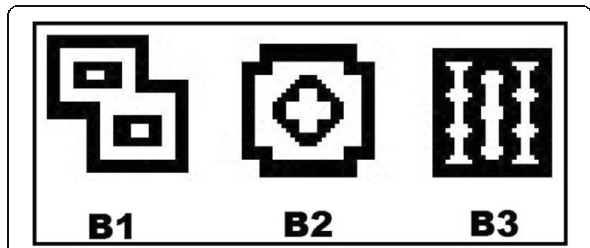
Fig. 1 Abstract stimuli experimentally named B1, B2, and